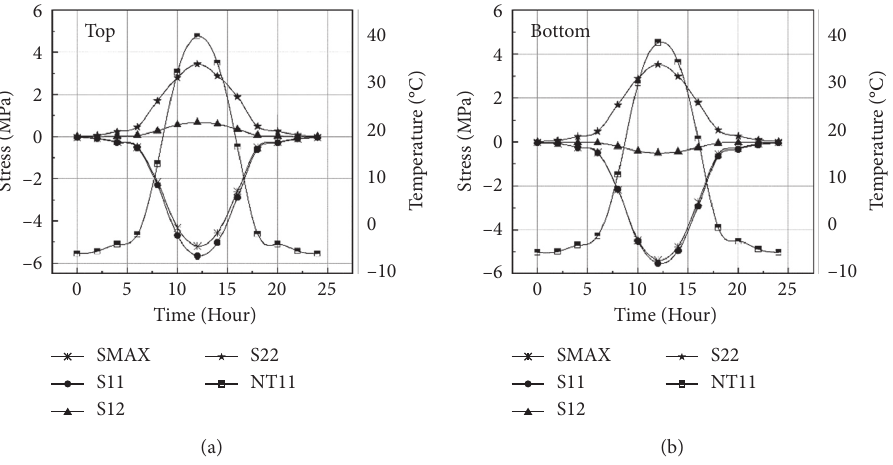
Figure 11: Time-history response curve of stresses above void area in the condition of after polymer grouting in the winter: (a) slab top and (b) slab